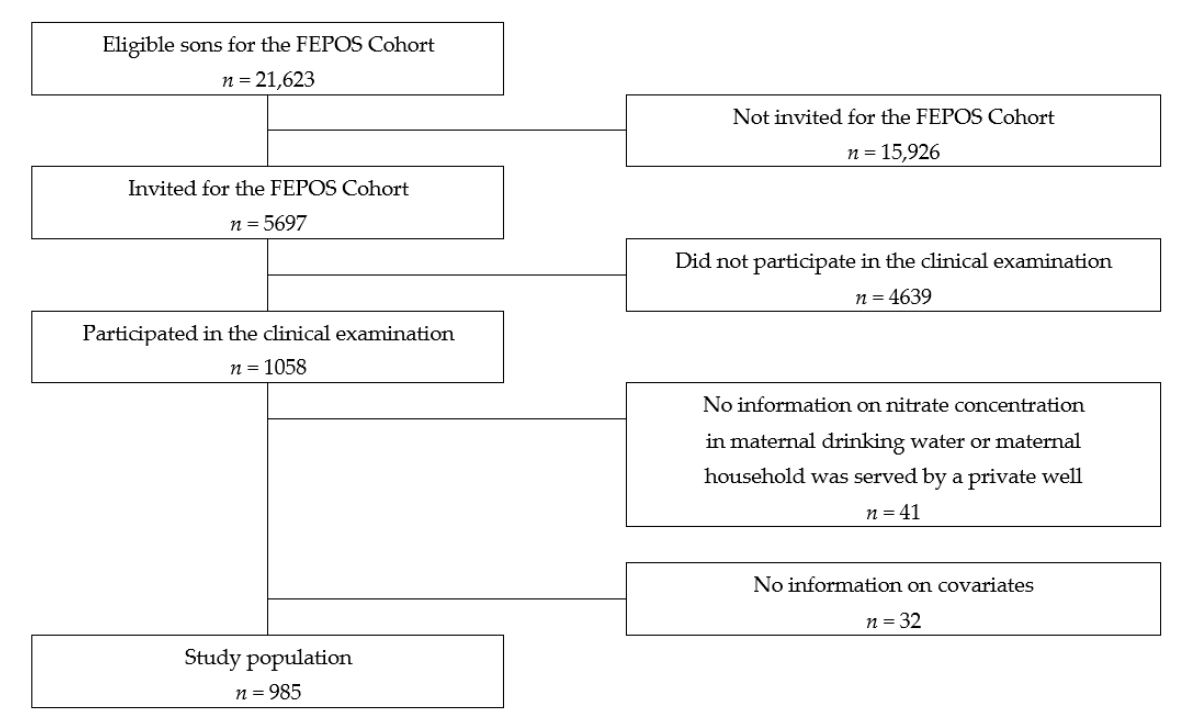
Figure 1. Flowchart of the recruitment of the study population.